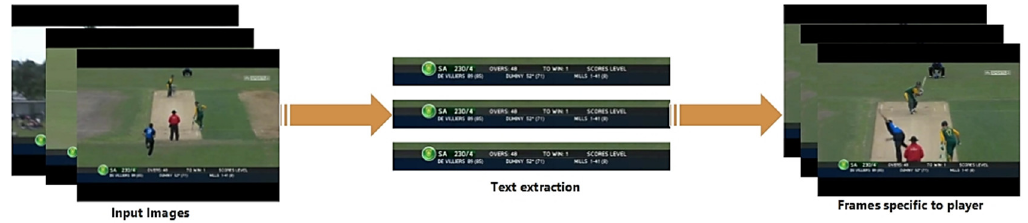
Figure 2. Extraction of Frames based OCR.